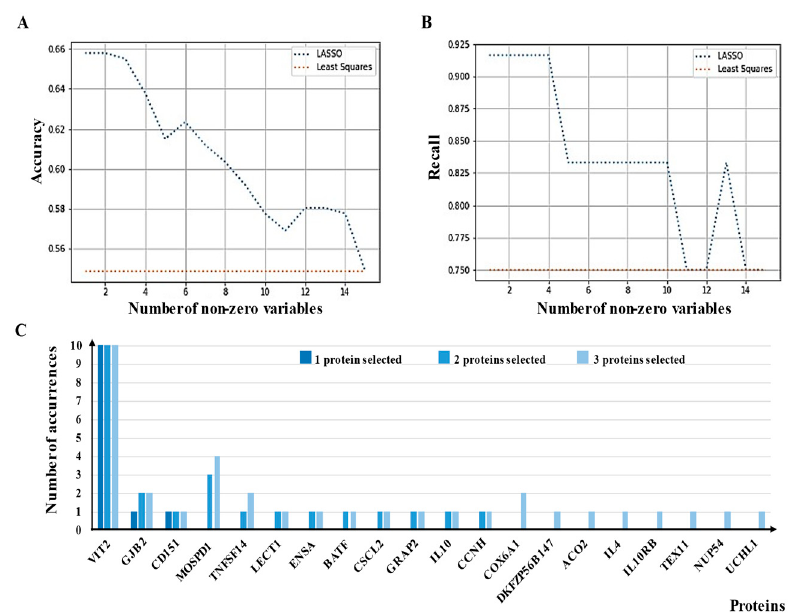
Figure 6. In silico prediction of a potential panel of TAAs as biomarkers for sCRC. ( A )—Accuracy evolution of the lasso algorithm versus number of proteins selected. ( B )—Recall evolution of the lasso algorithm versus number of proteins. ( C )—Histogram of proteins chosen by the lasso algorithm.